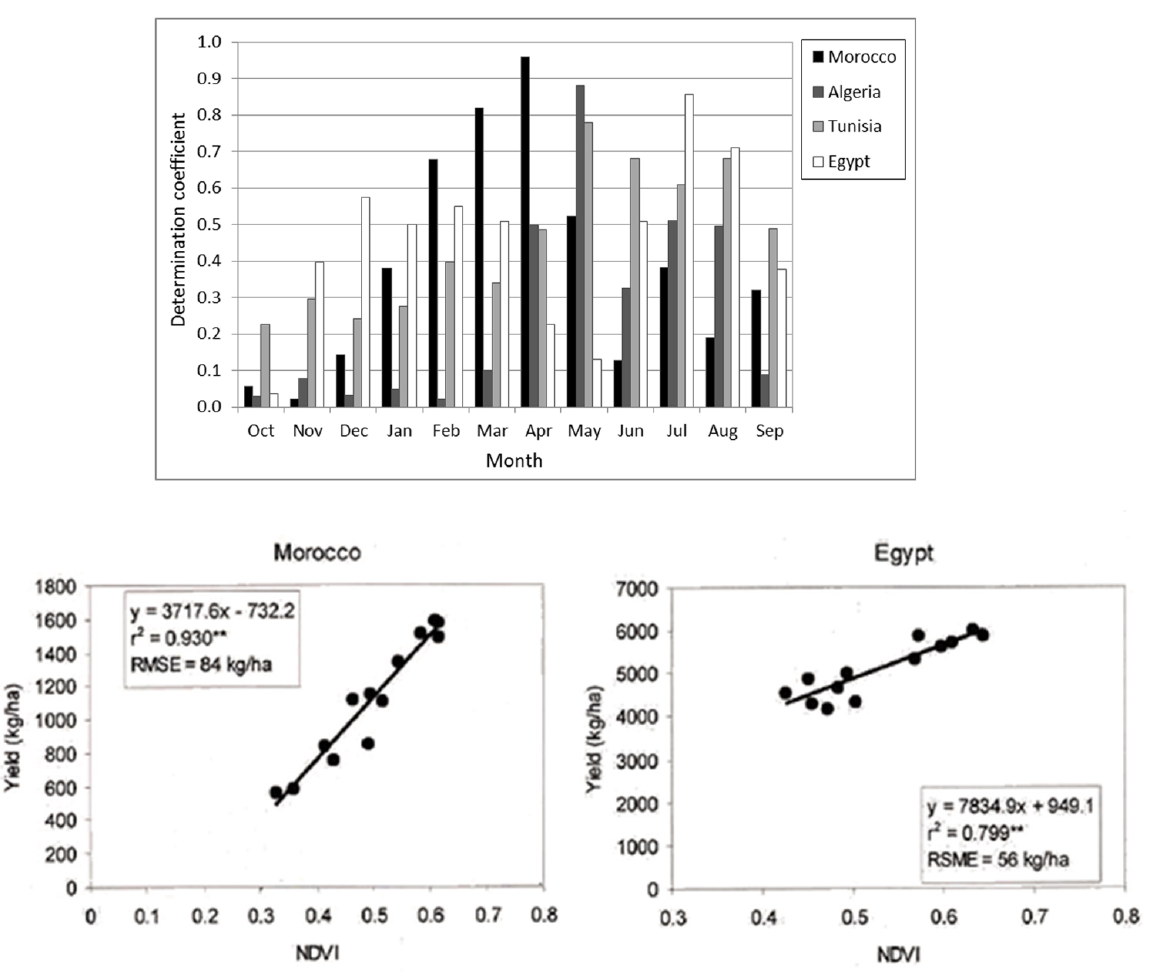
Figure 4. NDVI/yield linear regressions for cereals in North Africa (from Maselli and Rembold [46]; modified). ( Top ) Evolution of the coefficient of determination (R2) between radiometric variable and yield over time. ( Bottom ) Scatter plots between NDVI and cereal yield. Each dot corresponds to the annual yield for agricultural areas at national level and to the monthly NDVI best correlated to